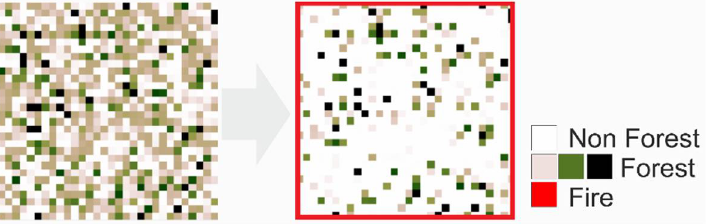
Figure 4. Fire model after Busing. On the left is the representation of the cellular automaton with no fire. In a cell, the biomass of the vegetation is shown—the darker the cell, the more biomass. On the right, fire has burned the entire area, but depending on fire tolerance, some trees survive. In this schematic visualization of a virtual landscape, one cell has the size of 20 m, and the total area is 30 × 30 cells.